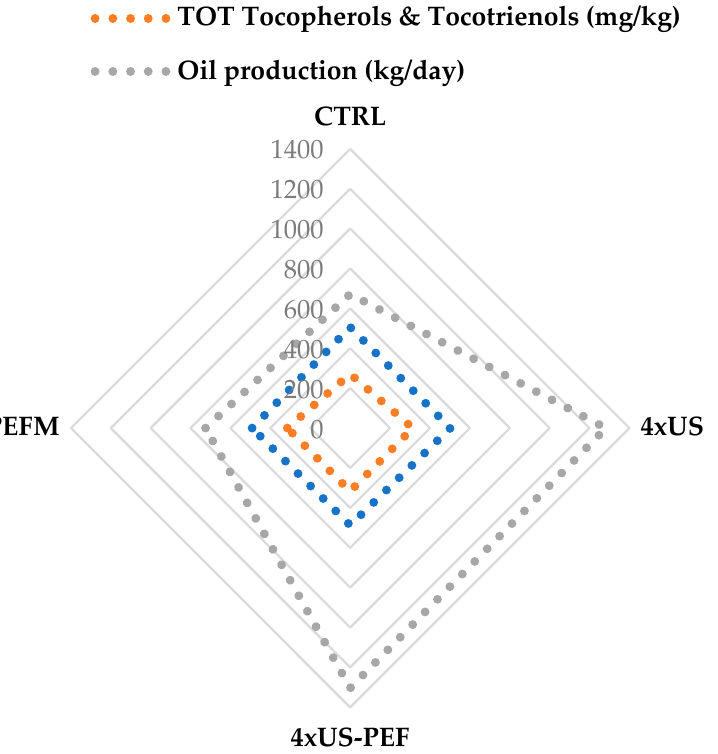
Figure 11. Technology comparison according to overall bio-phenols, tocopherols, tocotrienols and oil production.